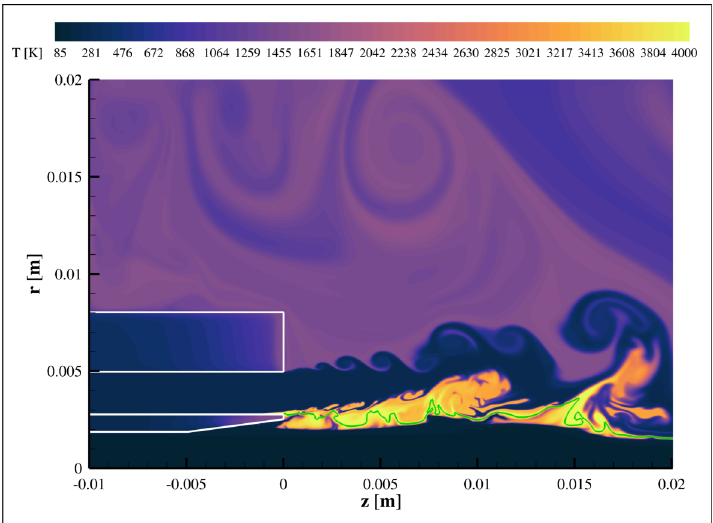
Figure 9. Numerical instantaneous distribution of temperature. The stoichiometric mixture fraction isoline Z = 0.11 is also shown in